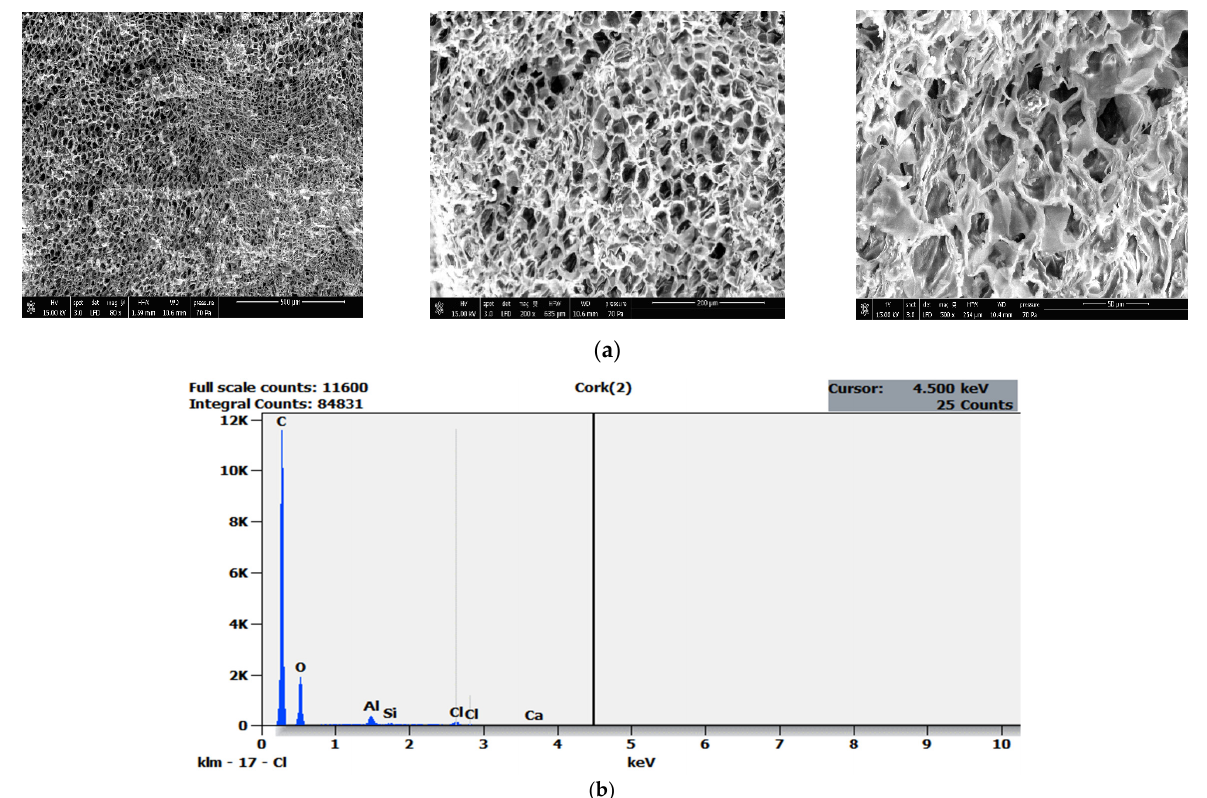
Figure 2. ( a ) Scanning electron microscopy (SEM) images and different magnifications of natural cork and ( b ) elemental analysis (EDX) at different magnifications of natural